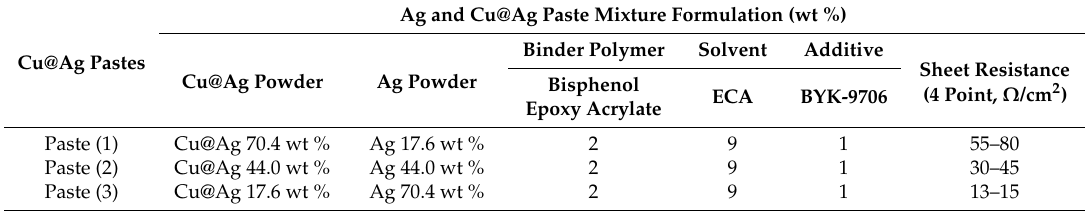
Table 4. Formulation of Ag and Cu@Ag nanoparticle mixture paste and